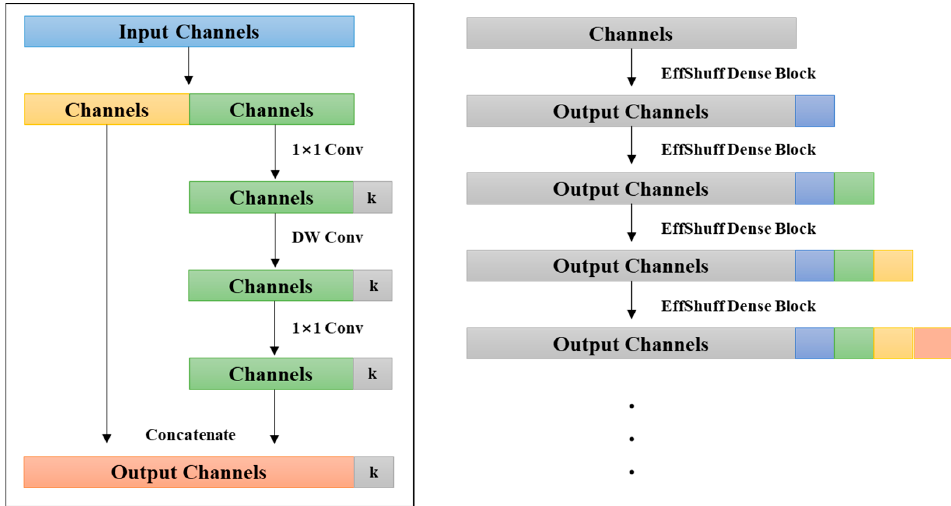
Figure 6. Details of EffShuff-Dense-Block. Table 2. EffShuff-Dense-Block model architecture.